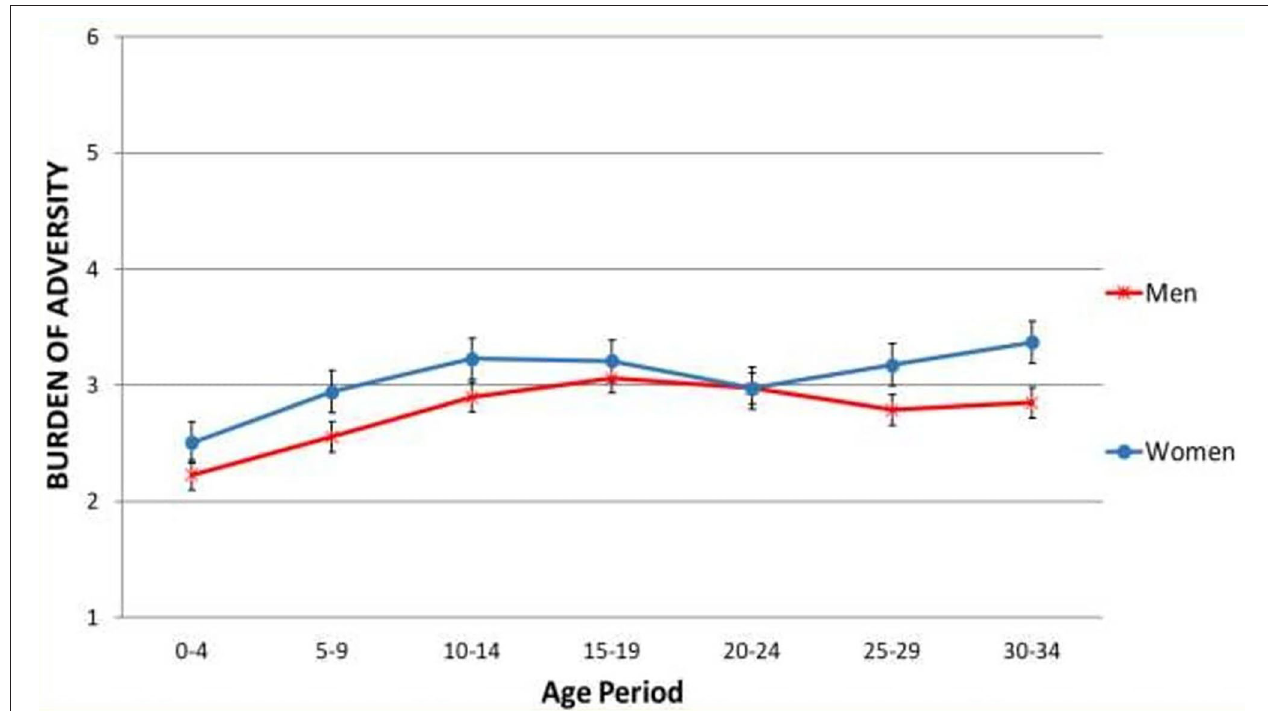
FIGURE 2 | Growth model analysis representing the burden of adversity trajectories. Vertical bars corresponds to standard